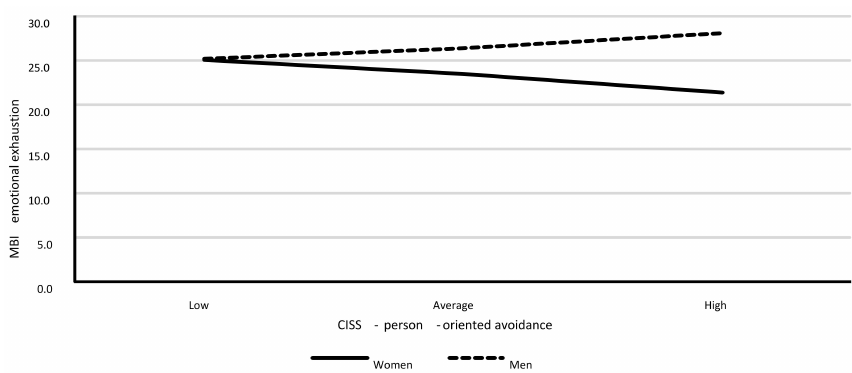
Figure 2. Associations between POA and emotional exhaustion for each gender separately.